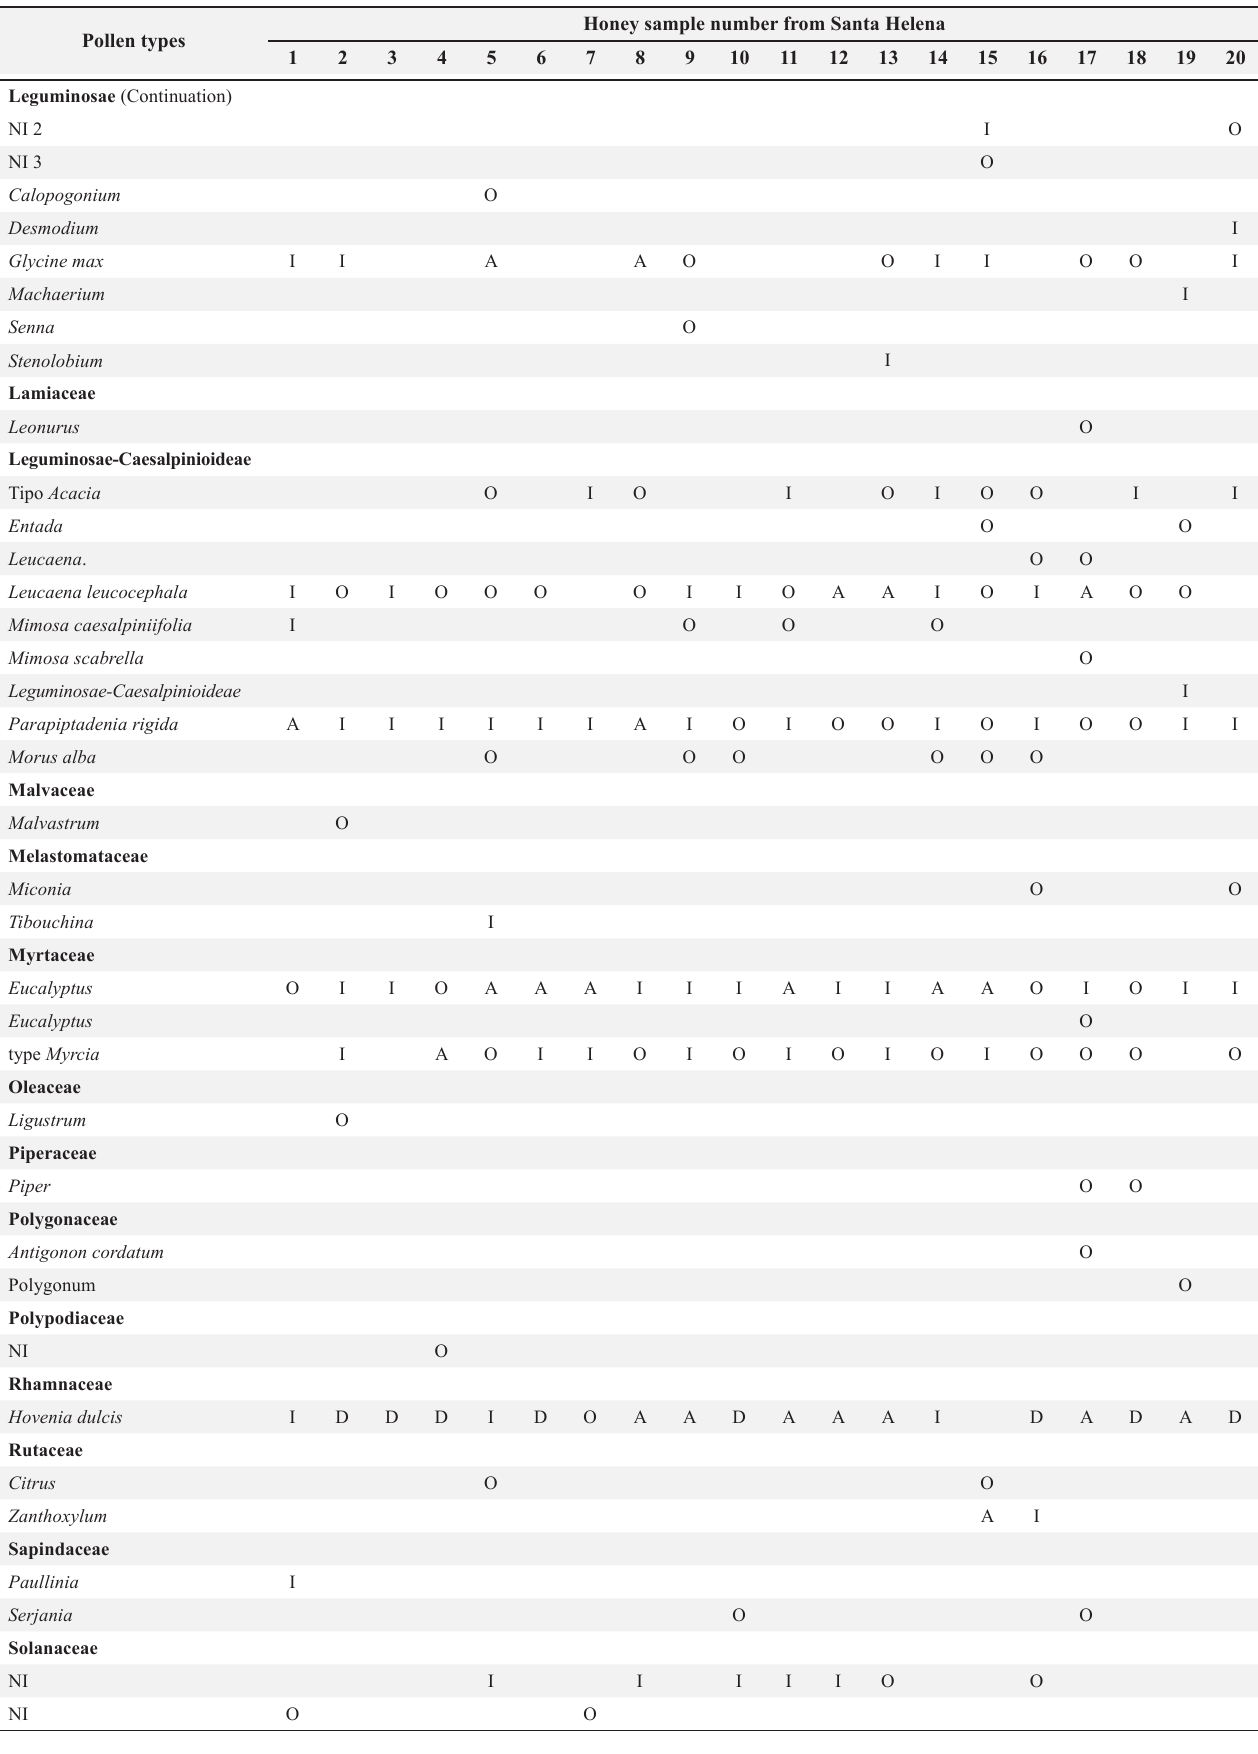
Table 1. Pollen types and frequency classes of: Santa Helena honey samples, where: D: dominant pollen (> 45%); A: accessory pollen